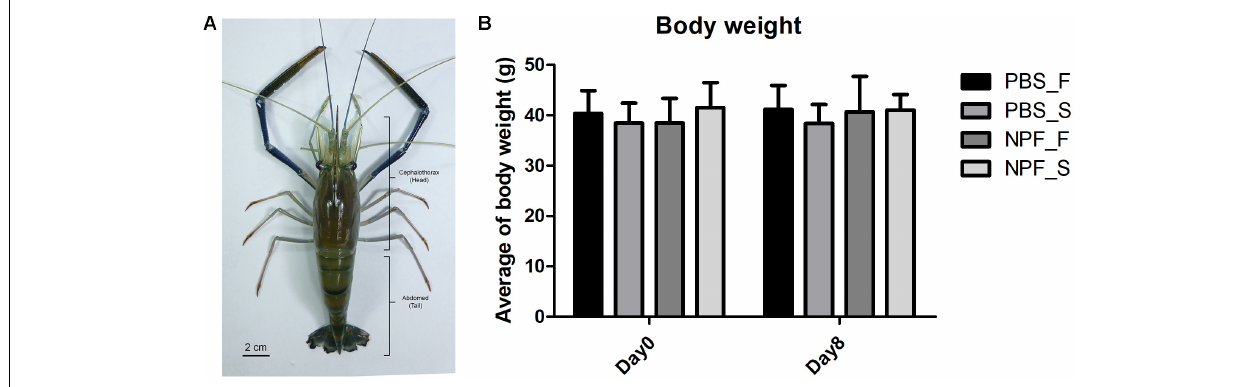
FIGURE 1 | Effect of neuropeptide F on an anatomical structure and the body weight of Macrobrachium rosenbergii . (A) An example of small male freshwater prawns used in the experiment. (B) The average weights of the prawns in the control and NPF-injected groups at day 8 (no significant